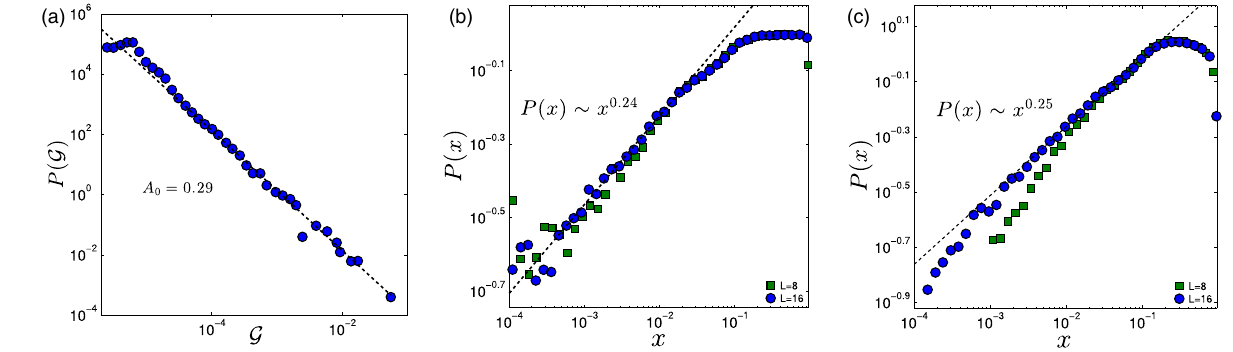
FIG. 9. (a) Direct measurements of A 0 as extracted from the distribution P ð G Þ of the Eshelby kernel in d ¼ 4 . We extract A 0 ¼ 0 . 29 (cid:3) 0 . 4 and predict θ MF 0 . 24 (cid:3) 0 . 04 . (b) P ð x Þ at Σ c using extremal dynamics for the shuffled Eshelby kernel for 4 D ¼